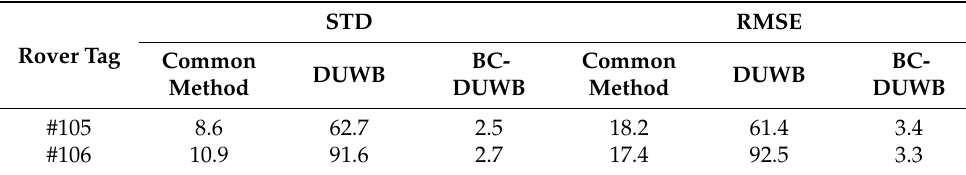
Table 5. STD and RMSE of Test 1 with Different Methods